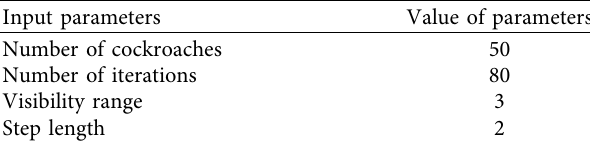
Table 24: Initial parameters of cockroach.